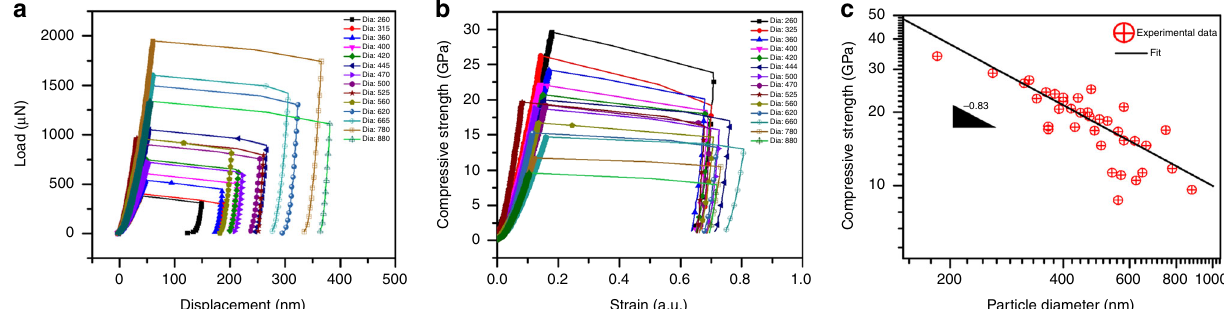
Fig. 3 Results of mechanical testing of Ni nanoparticles. a Typical load – displacement curves for several particle sizes. b Engineering stress – strain curves demonstrate that the strength increases with decreasing particle diameter. c Compressive strength as a function of particle